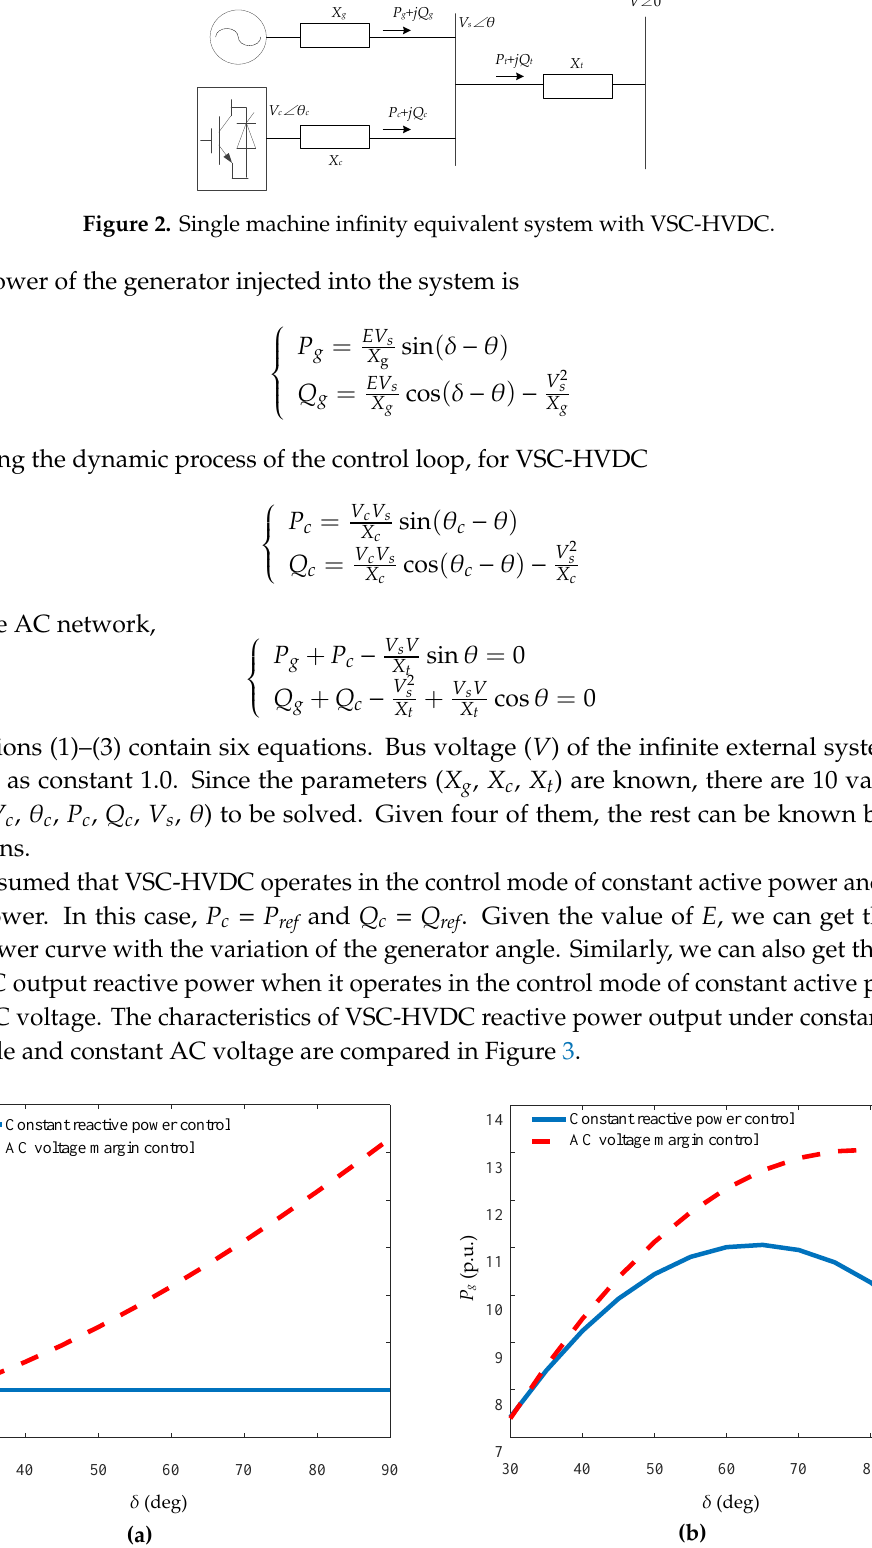
Figure 3. Comparisons of di ff erent VSC-HVDC control strategies of q-axis current. ( a ) VSC-HVDC reactive power; ( b ) generator’s power